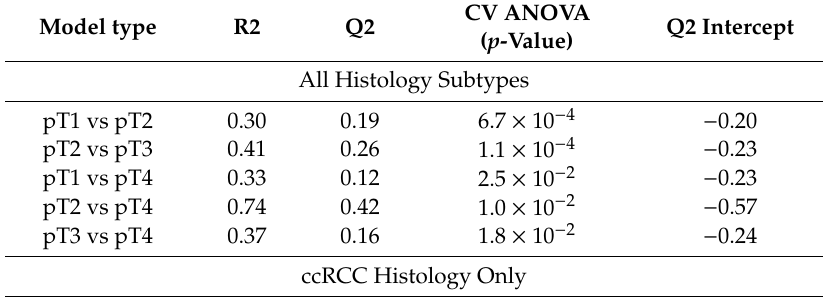
Appendix A Table 1A. Statistical metrics of group separation between RCC stages of all histology subtypes and between RCC stages of ccRCC histology subtype from orthogonal partial least squares discriminant analysis (OPLS-